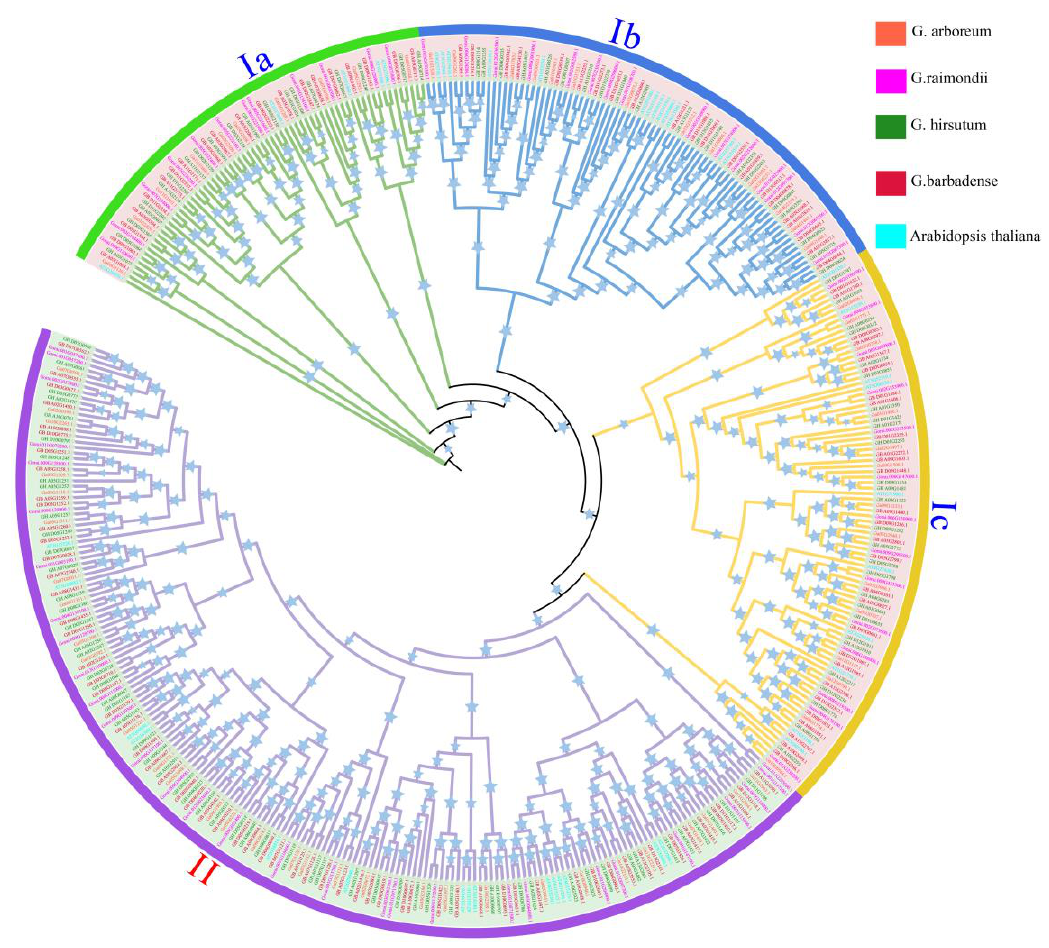
Figure 1. Phylogenetic tree of the ATP-binding cassette transporter G (ABCG) family in four Gossypium species and Arabidopsis. A total of 69, 71, 124 and 131 ABCG members identified in G. arboretum, G. raimondii , G. hirsutum and G. barbadense , respectively, together with 43 Arabidopsis ABCGs were submitted for phylogenetic analysis. Ia, Ib, Ic and II represent 4 subgroups.